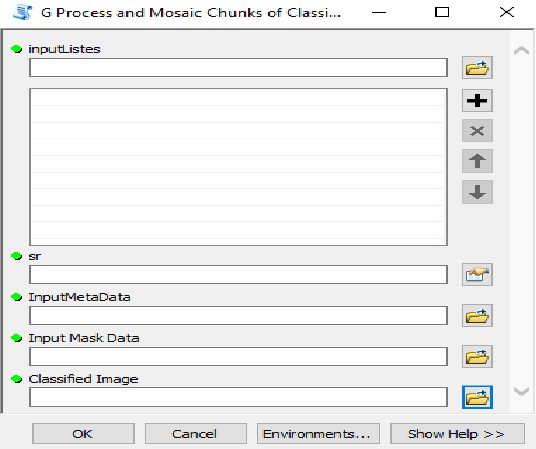
Figure 4 G Tool Parameterization (Process and Mosaic Chunks of Classified